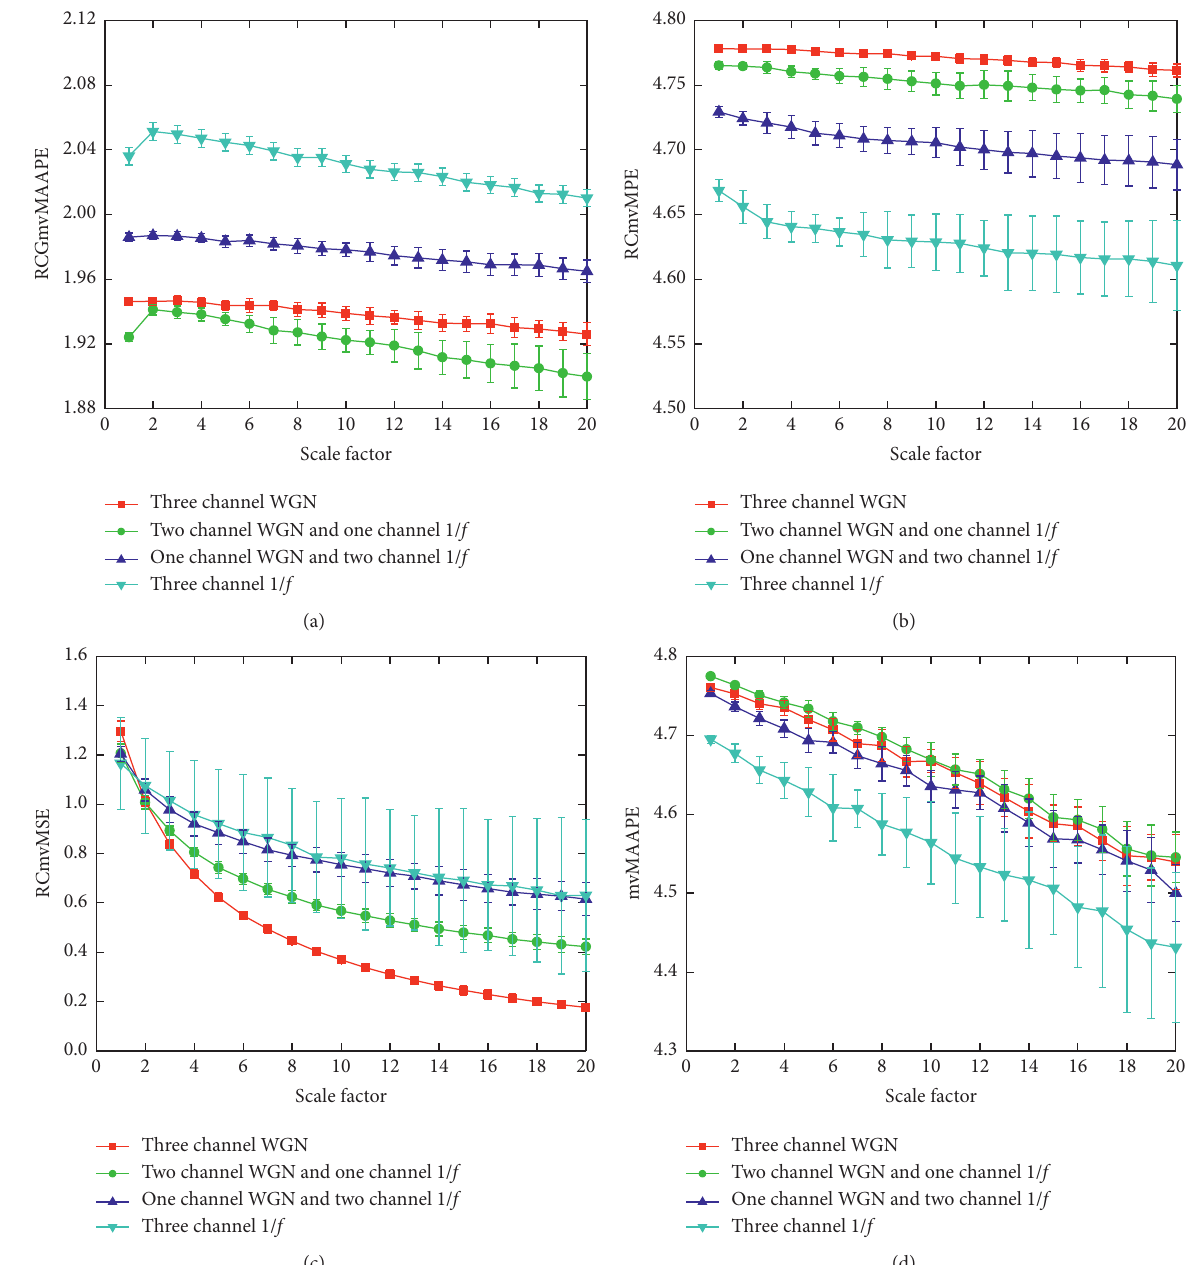
Figure 5: RCGmvMAAPE, RCmvMPE, RCmvMSE, and mvMAAPE of four multichannel synthetic